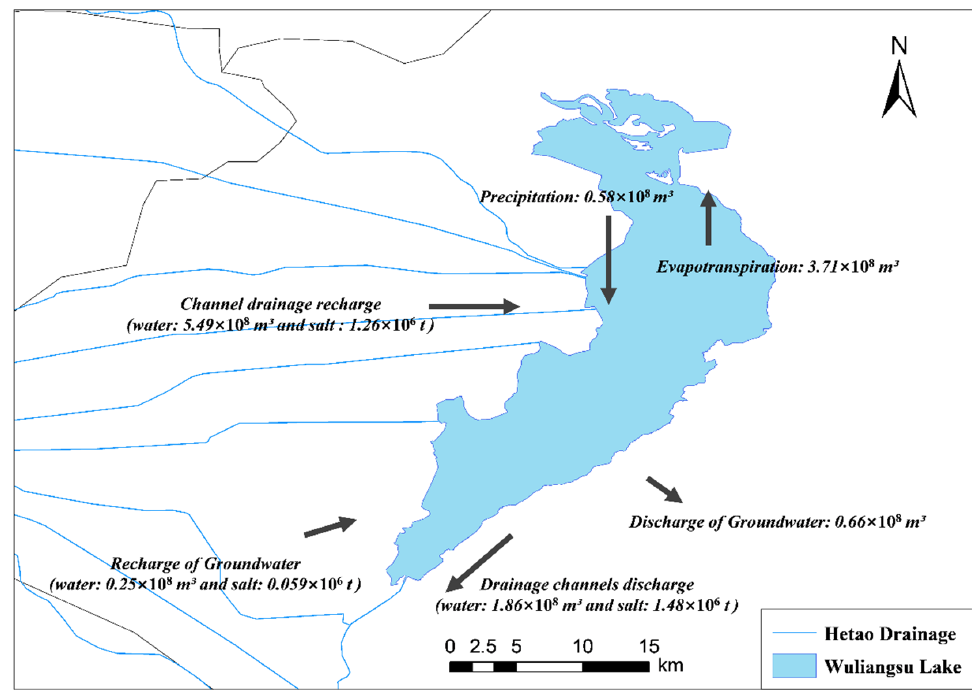
Figure 6. Diagram of water and salt equalization in Wuliangsu Lake.